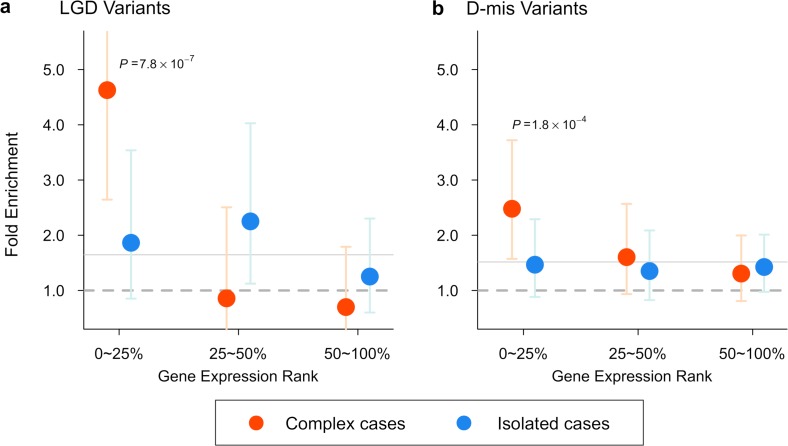
Burden of damaging de novo variants in different gene sets and sub classes of CDH.(a) In complex cases, LGD variants were dramatically (4.6 fold) enriched in genes highly expressed (ranked in the top quartile) in mouse developing diaphragm (MDD) [34], and showed no enrichment in other quartiles. By comparison in isolated cases, LGD variants showed similar enrichment (~2 fold) across expression levels. (b) D-mis variants carried by complex cases also showed highest (2.4 fold) enrichment in the top quartile of MDD expression. Enrichment was evaluated by comparing observed number of variants to the baseline expectation[23, 70] using a one-sided Poisson test. Bars represent the 95% confidence intervals of estimated fold enrichment.